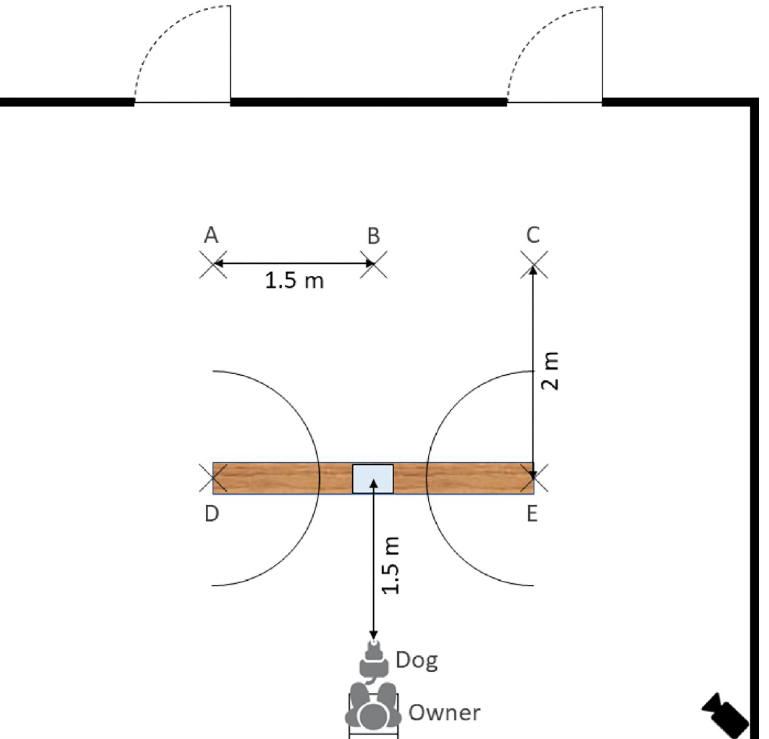
Fig 2. Schematic depiction of the experimental set-up. A and C indicate where the experimenters stood and B indicates where the beggar stood in the observation phase. D and E indicate where the experimenters stood in the test phase. The positions were marked by tape on the